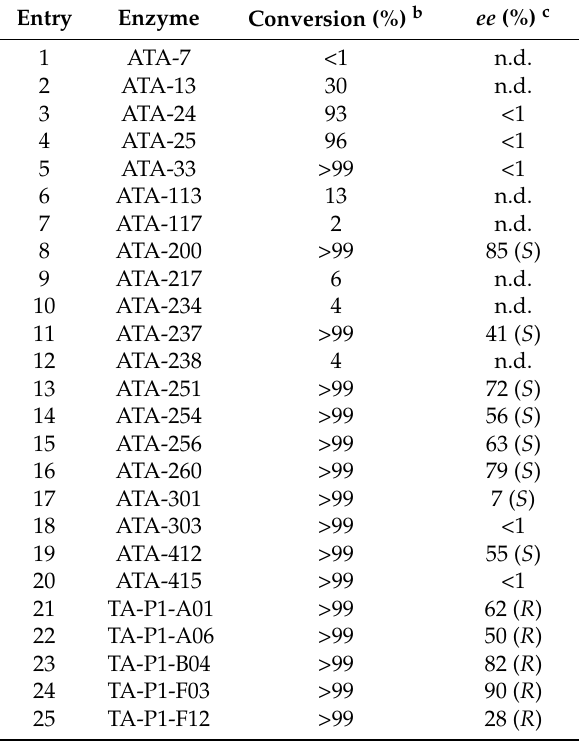
Table 1. Biotransamination of ketone 6 using Codexis ATAs. a